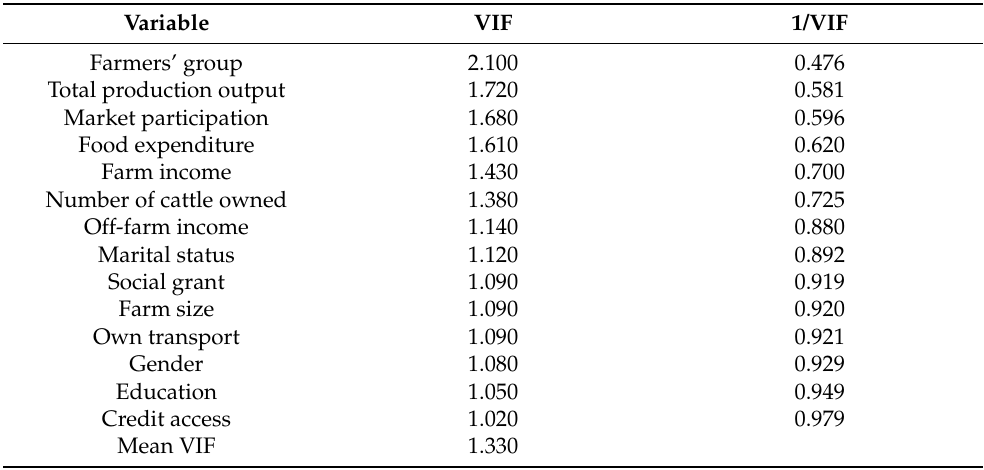
Table 5. Variable Variance Inflation Factors.